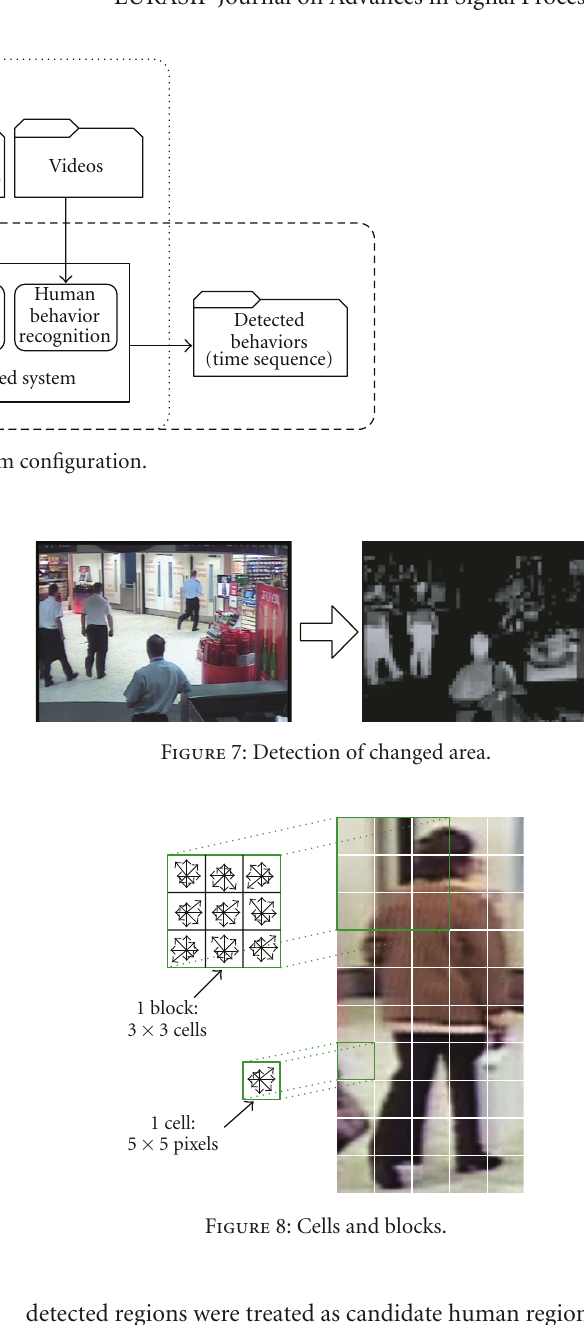
Figure 6: Flow for human region detection.